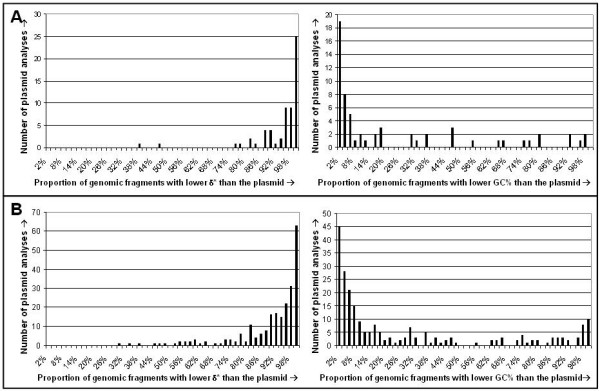
Distribution of the percentages of genomic fragments with a lower δ* or lower GC content than that of the plasmid. A) 61 plasmids compared to the genome sequence of the same strain. B) 230 plasmids compared with a single corresponding representative genome sequence.